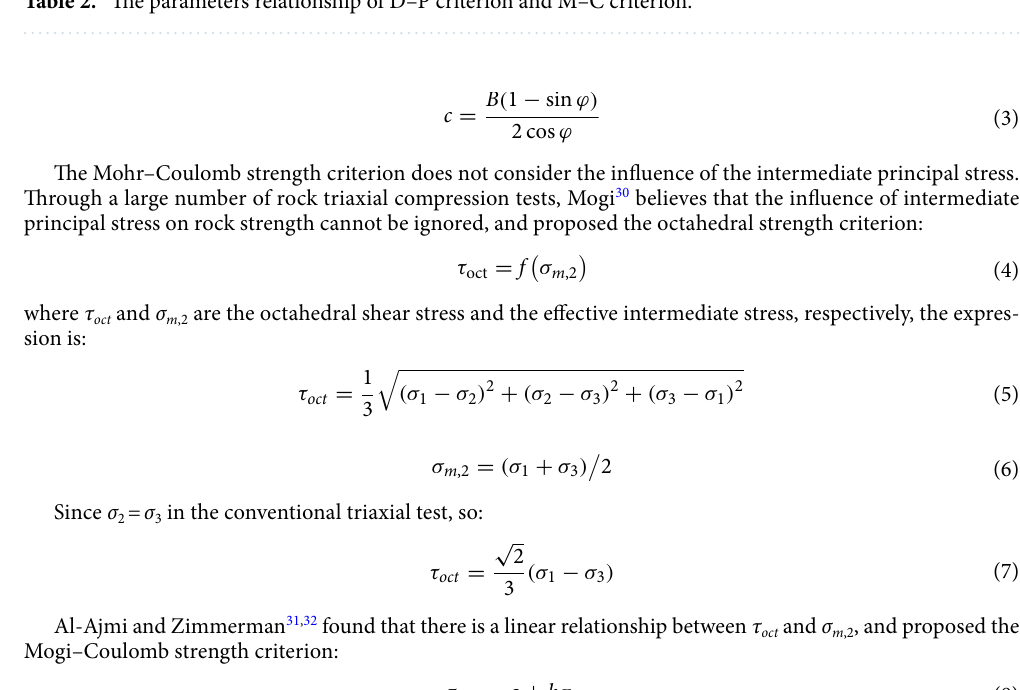
Table 2. The parameters relationship of D–P criterion and M–C